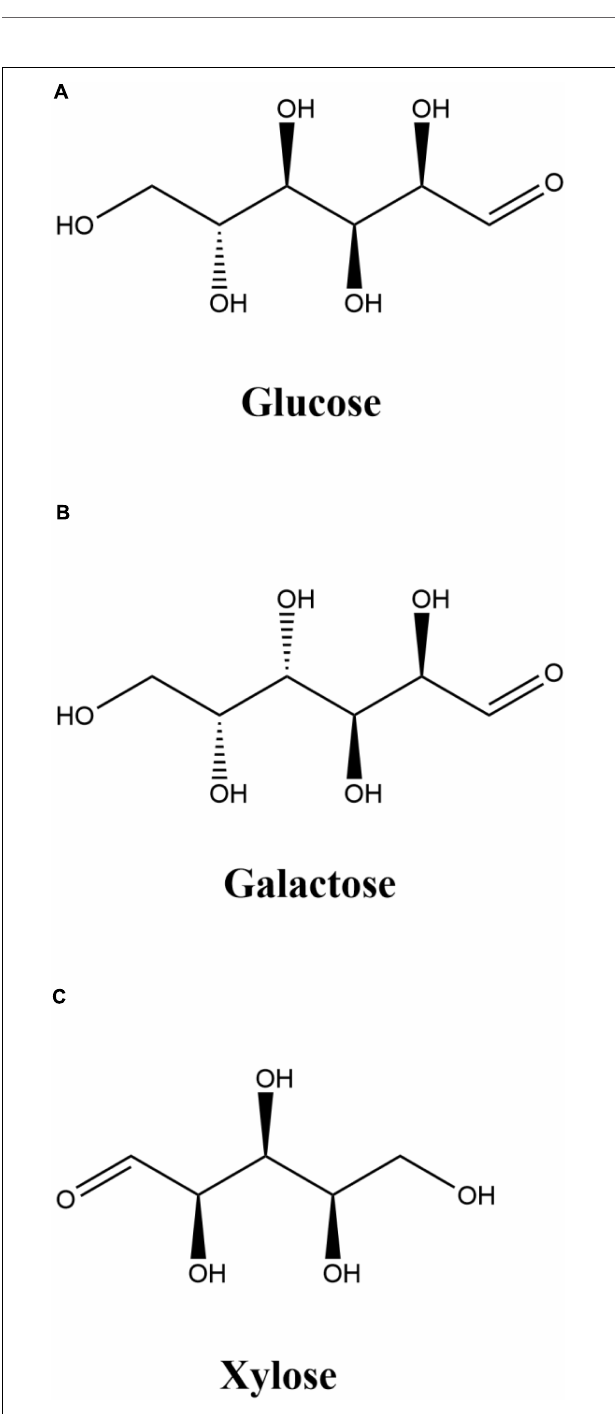
FIGURE 1 | Structures of glucose, galactose, and